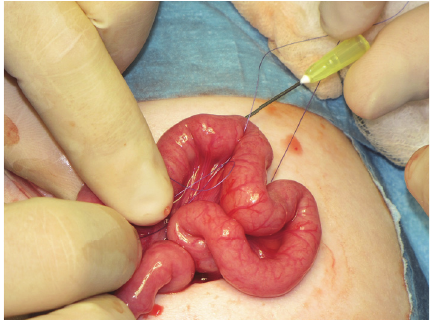
Figure 2: Insertion of the guide thread into the jejunal loop through the bore of a long injection needle (same patient as in Figure 1).